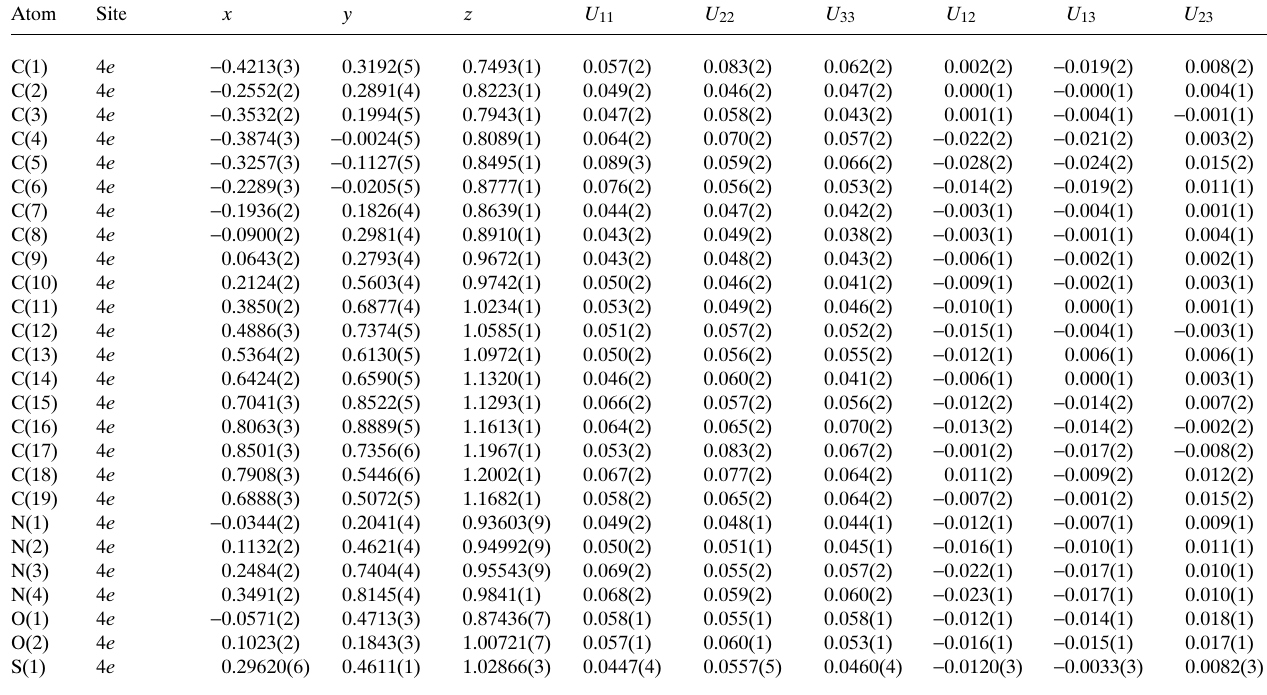
Table 3. Atomic coordinates and displacement parameters (in Å 2 ) . Atom